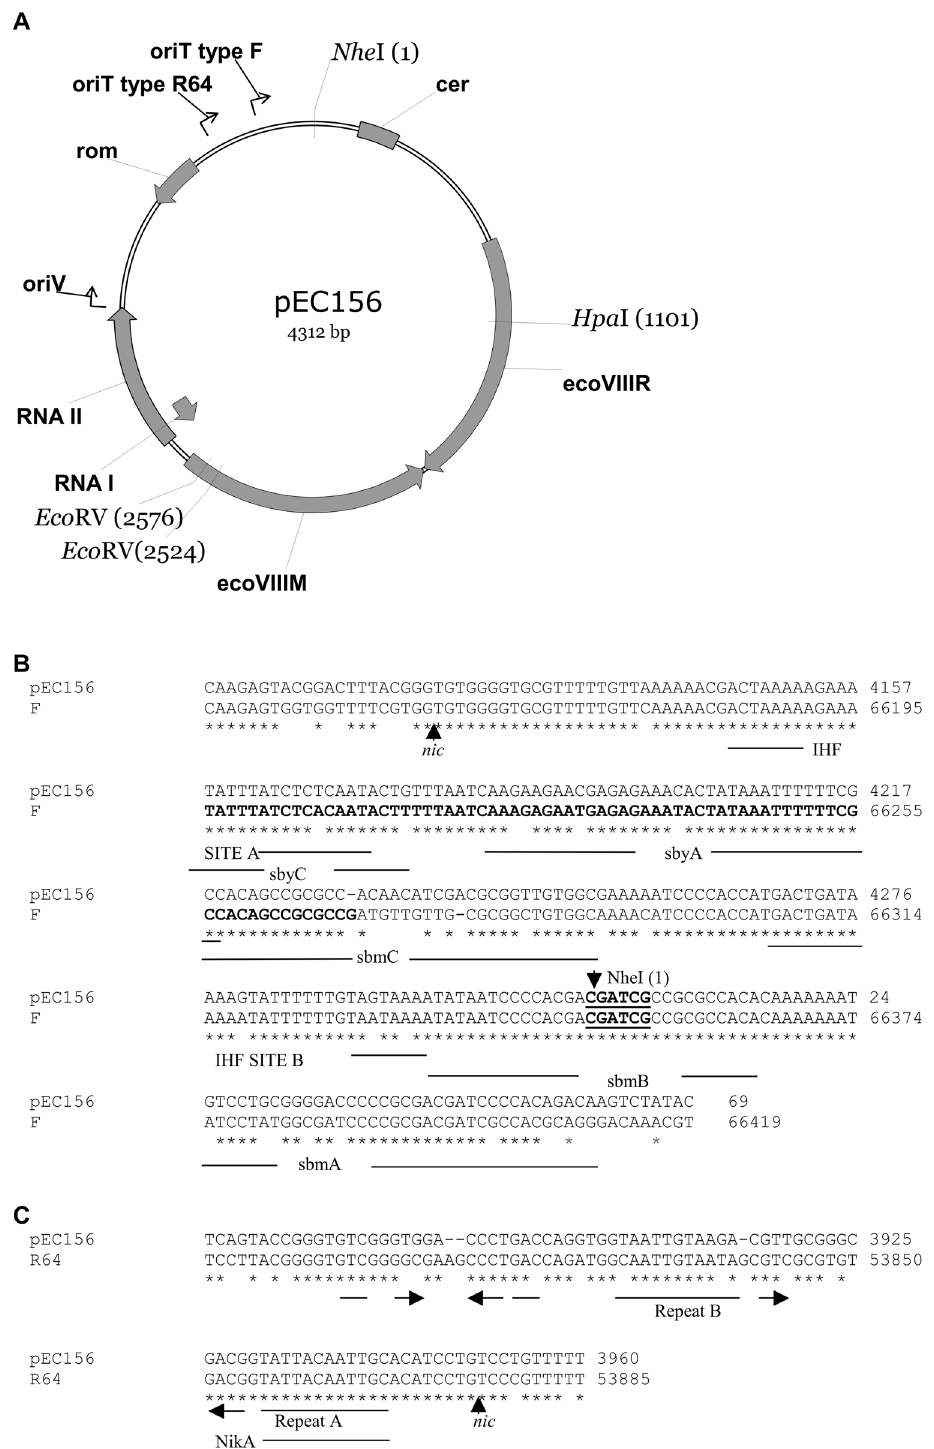
Fig 1. A map of plasmid pEC156 ( A ). The genes coding for the EcoVIII RM system, cer locus, rom gene as well as regions with oriT F-like, oriT R64-like sequences and genes that are engaged in the priming (RNA II) and controlling the initiation of plasmid DNA replication (RNA I) are indicated. Alignment of the pEC156 nucleotide sequence with oriT of F plasmid ( B ) and oriT of R64 plasmid ( C ). The minimal region that allows oriT F-dependent plasmid mobilization is in boldface. The position of nick sites ( nic ) are indicated. Binding